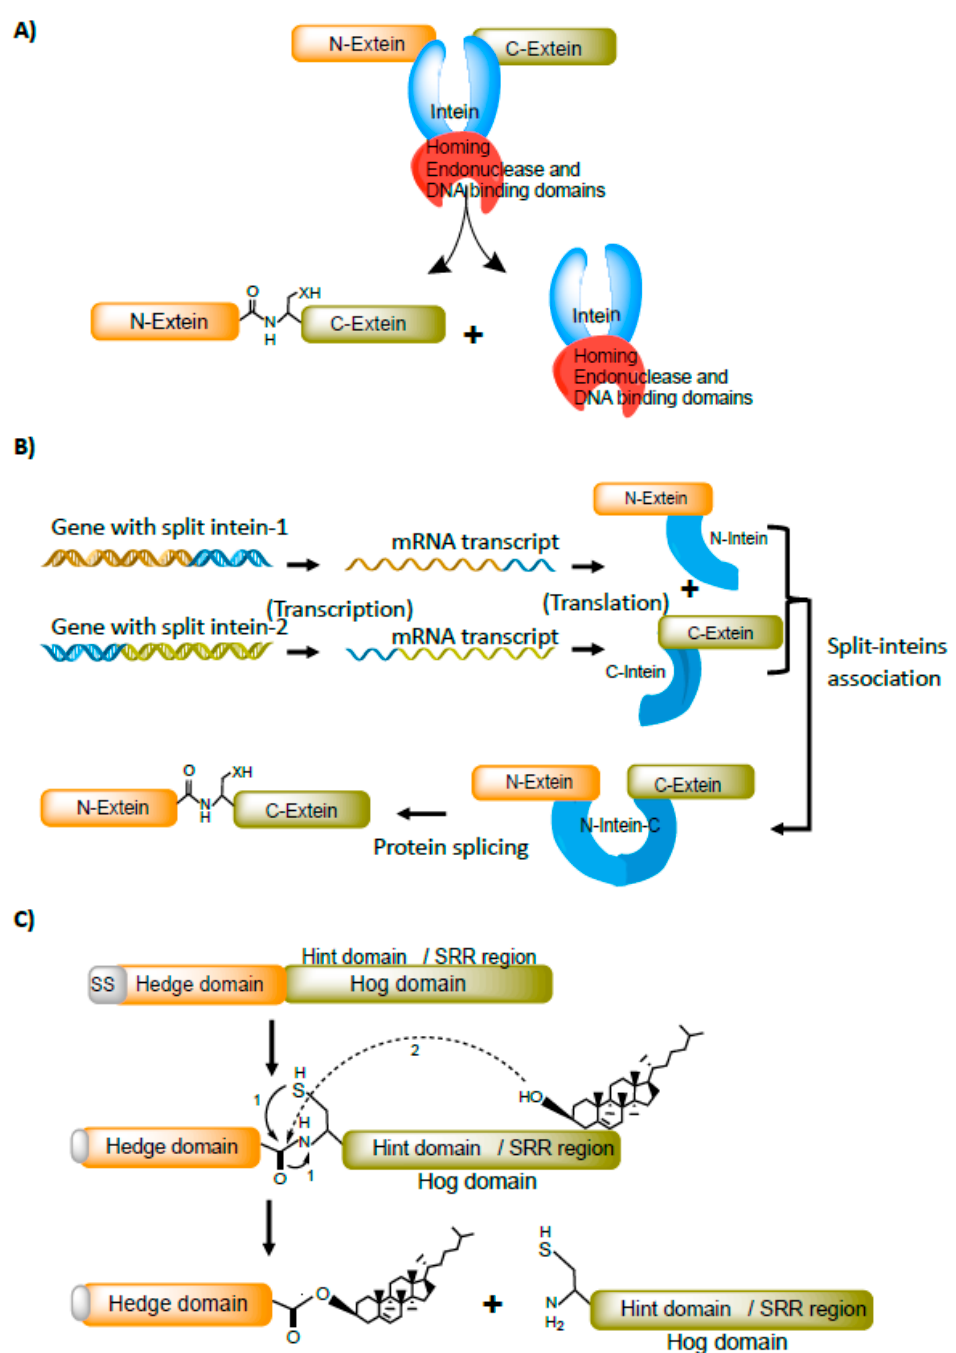
Figure 1. Different forms of the hint domain. ( A ) Inteins containing homing endonuclease (HE) and DNA binding domains. Inteins with HED are selfish genetic mobile elements capable of integrating into the alleles. ( B ) Split inteins are trans- splicing elements that are transcribed and translated separately and have the ability to associate in-trans , and splice out. ( C ) Hedgehog proteins with hint domain (hog domain). The conserved glycine and cysteine residues rearrange to form a thioester bond (step-1; N to S acyl rearrangement). The hydroxyl group of cholesterol attacks thioester bond (step-2; trans -esterification) and links cholesterol to the hedge domain releasing hog domain. SS, a processed signal-sequence peptide at the N-terminus of the Hedge domain.